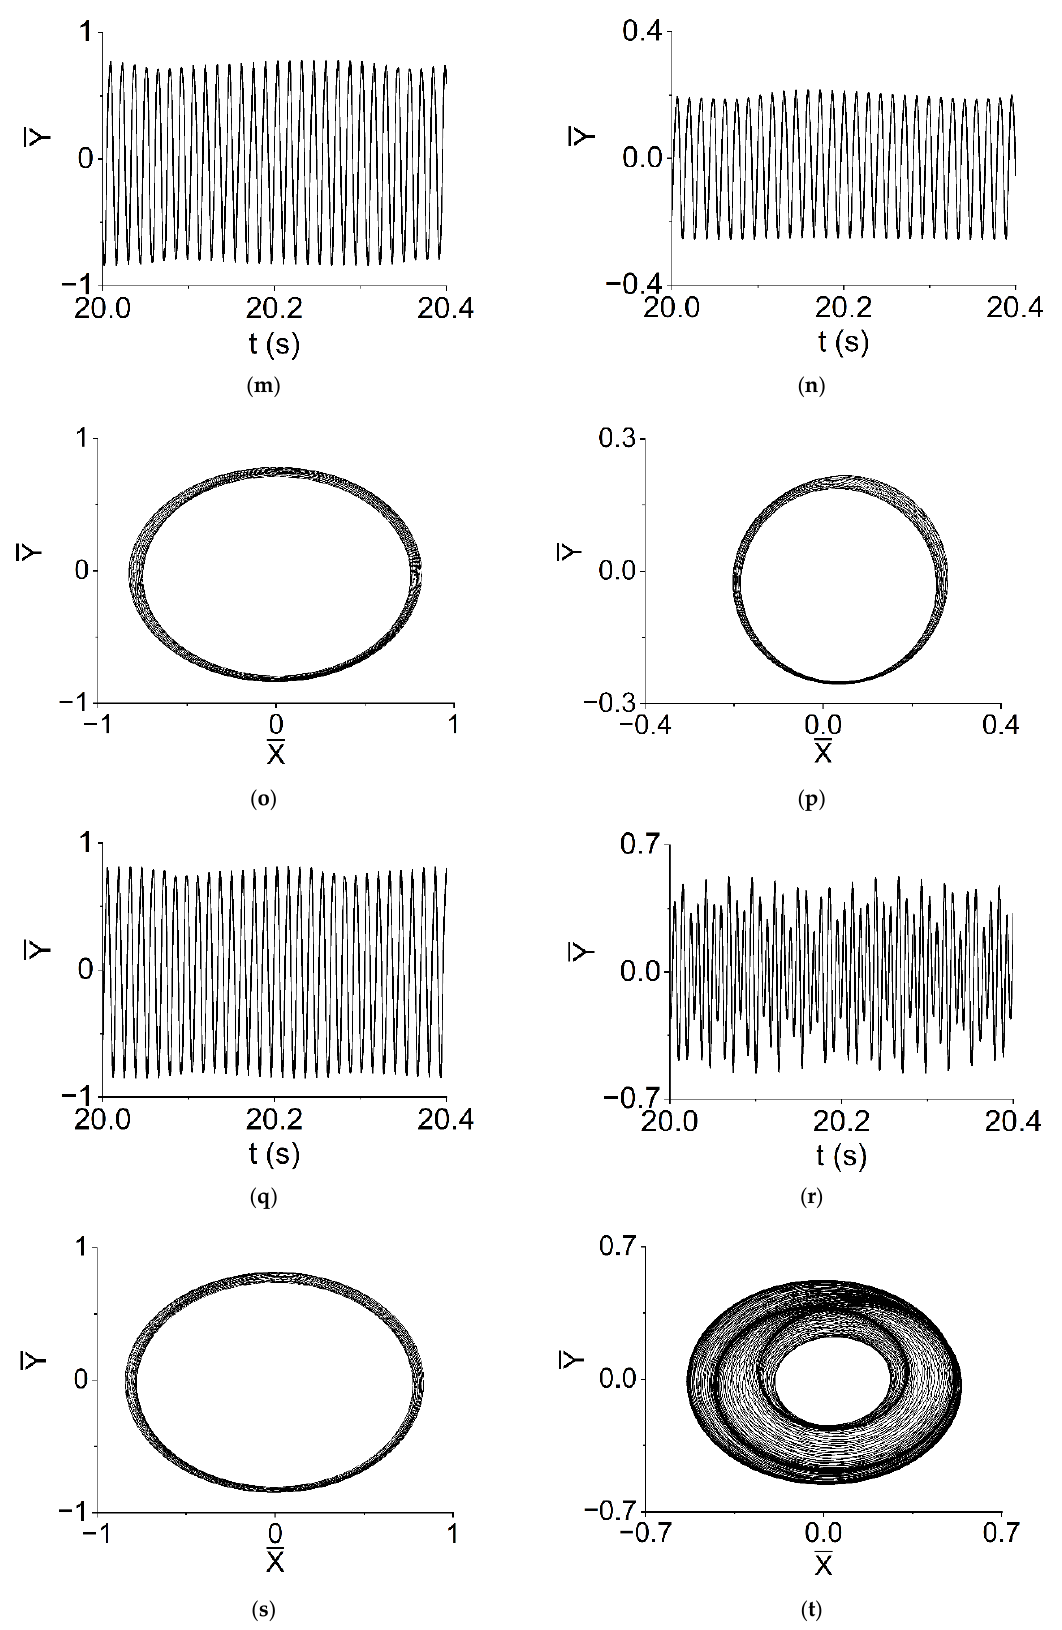
Figure 14. Y-displacements and trajectories of rotor system. ( a ) Y-displacement of rotor with Ω = 300 rad/s, ( b ) Y-displacement of bearing with Ω = 300 rad/s, ( c ) Trajectory of rotor with Ω = 300 rad/s, ( d ) Trajectory of bearing with Ω = 300 rad/s, ( e ) Y-displacement of rotor with Ω = 880 rad/s,